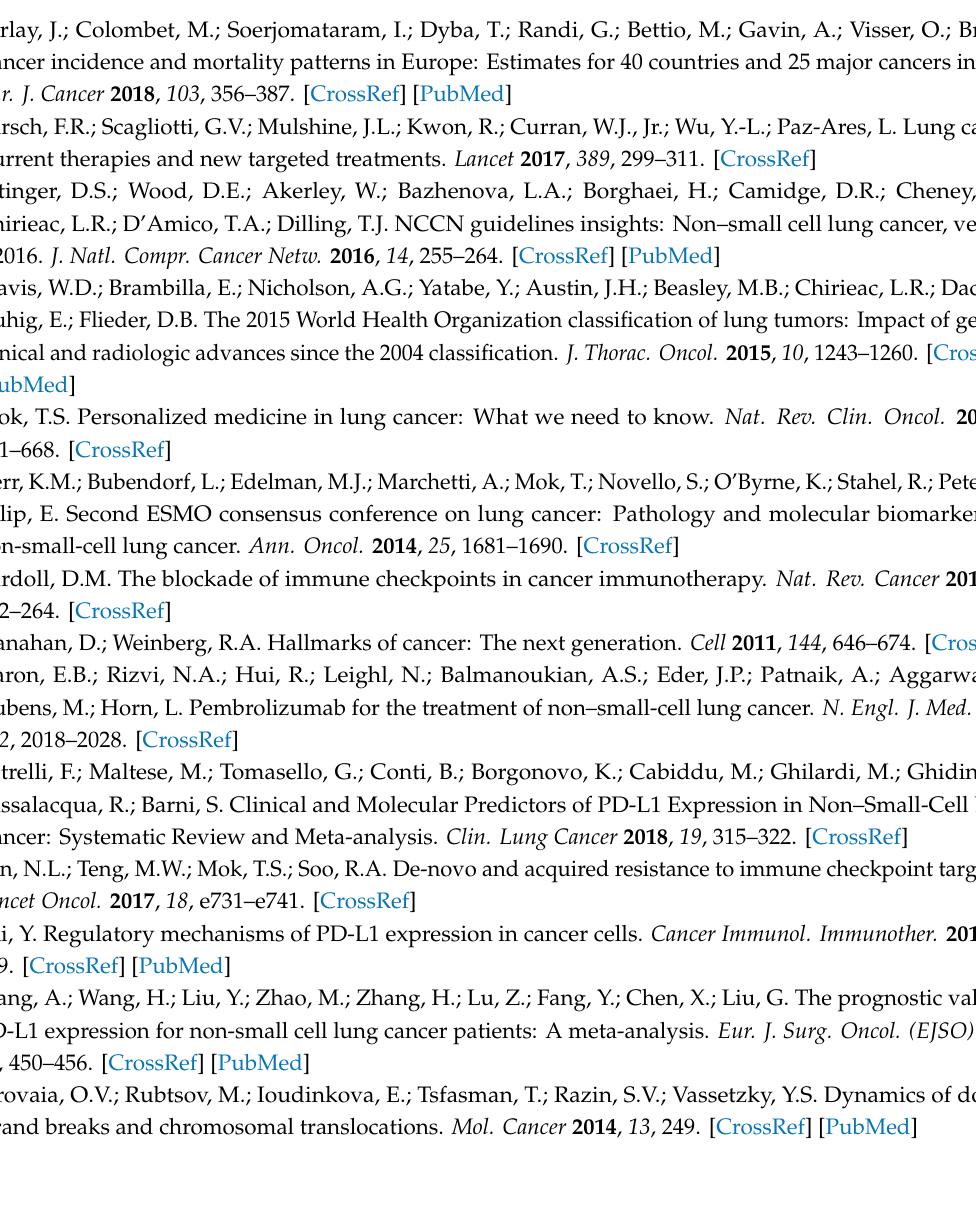
Table S1: Logistic regression analysis; Table S2: Multivariable analysis for progression-free survival; Table S3: Multivariable analysis for overall